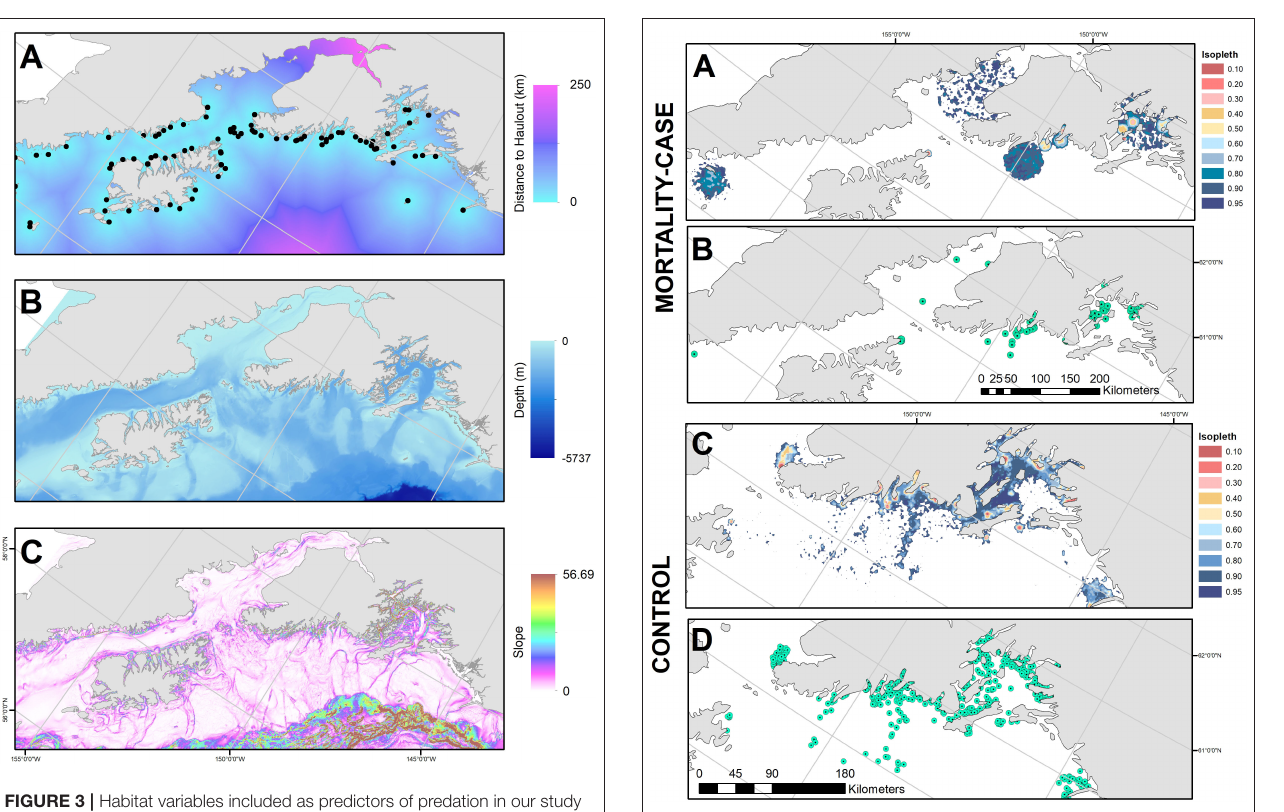
FIGURE 4 | (A) The mortality occurrence probability distribution, and (B) the generated case locations ( n = 100) from which habitat features were extracted. (C) The control utilization distributions from Bishop et al. (2018), and (D) the generated control locations ( n = 1,000), from which habitat features were